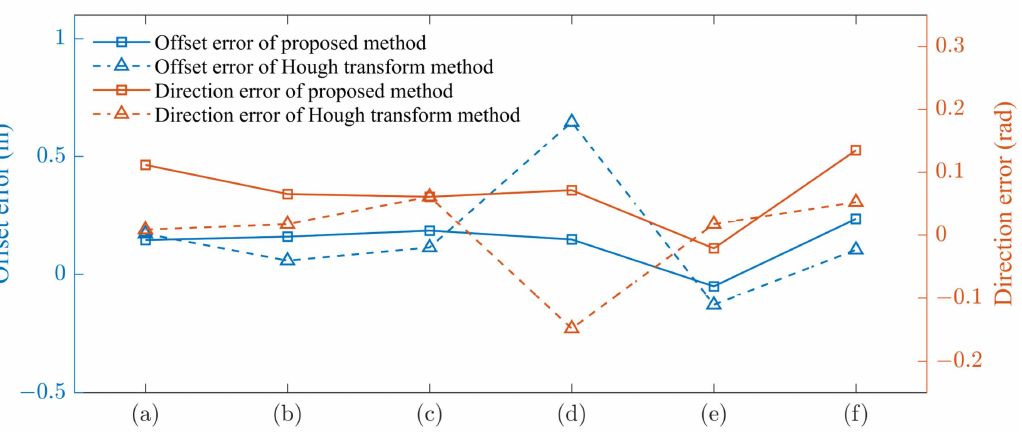
Figure 8. The offset error and direction error of different methods corresponding to ( a – f ) in Figure